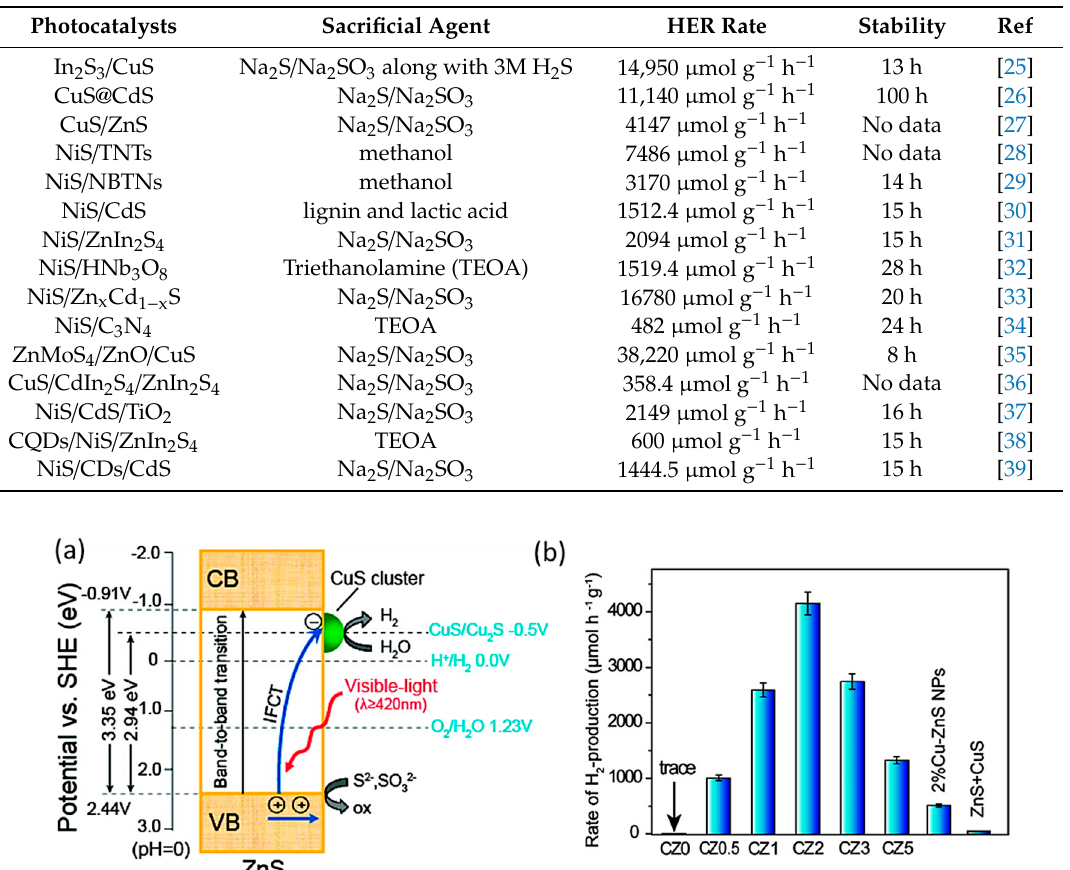
Table 1. Summary of CuS and NiS based heterojunctions for photocatalytic H 2 evolution. CQDs refers to Carbon Quantum Dots. Figure 3. ( a ) Photocatalytic process of In 2 S 3 /CuS composites under visible light irradiation. Adapted with permission from [25]; ( b ) the H 2 evolution rate by CuS, CdS, CuS@CdS-I, and CuS@CdS-L photocatalysts; ( c ) schematic illustration about the growth of CdS on CuS nanoplate seeds with two